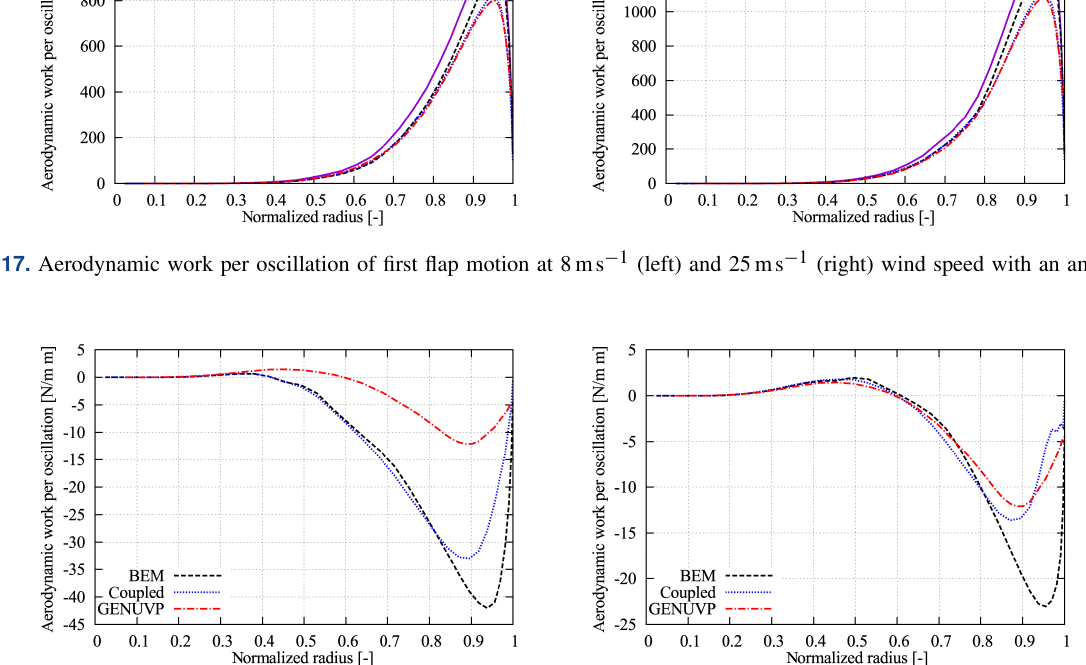
Figure 18. Aerodynamic work per oscillation of first edge motion at 8ms − 1 at an amplitude of 1m. Drag has been excluded, and C L = 2 πα . In the left plot, α QS is used in the unsteady airfoil aerodynamics model in both coupled model and BEM (see Eqs. 8–11). In the right plot, the unsteady airfoil aerodynamics model uses α QS − α 0 (see Eq. 20), improving the agreement with the free-wake code